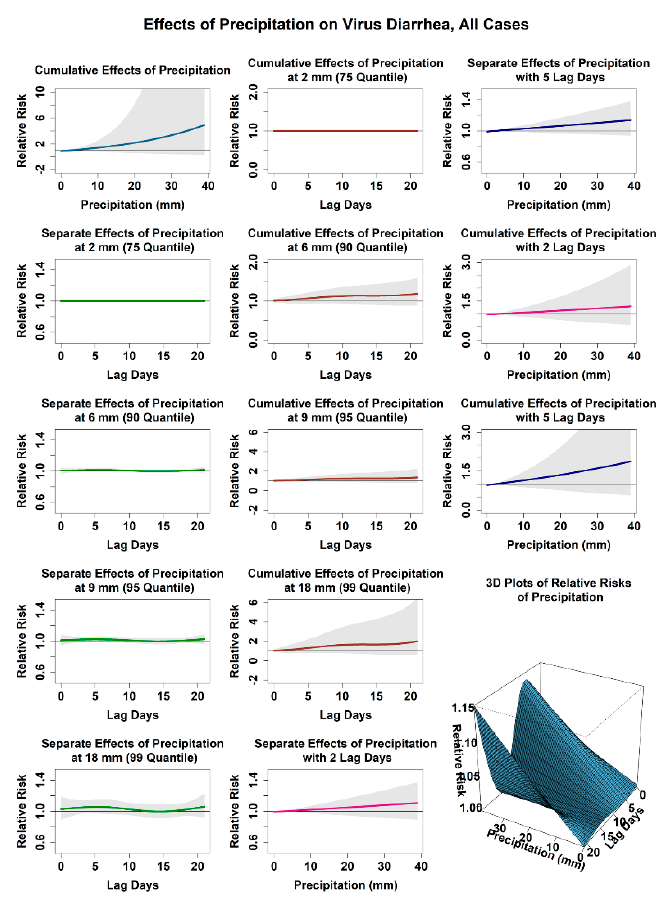
Figure 3. Effect of precipitation on virus diarrhea in Jilin Province, all cases.